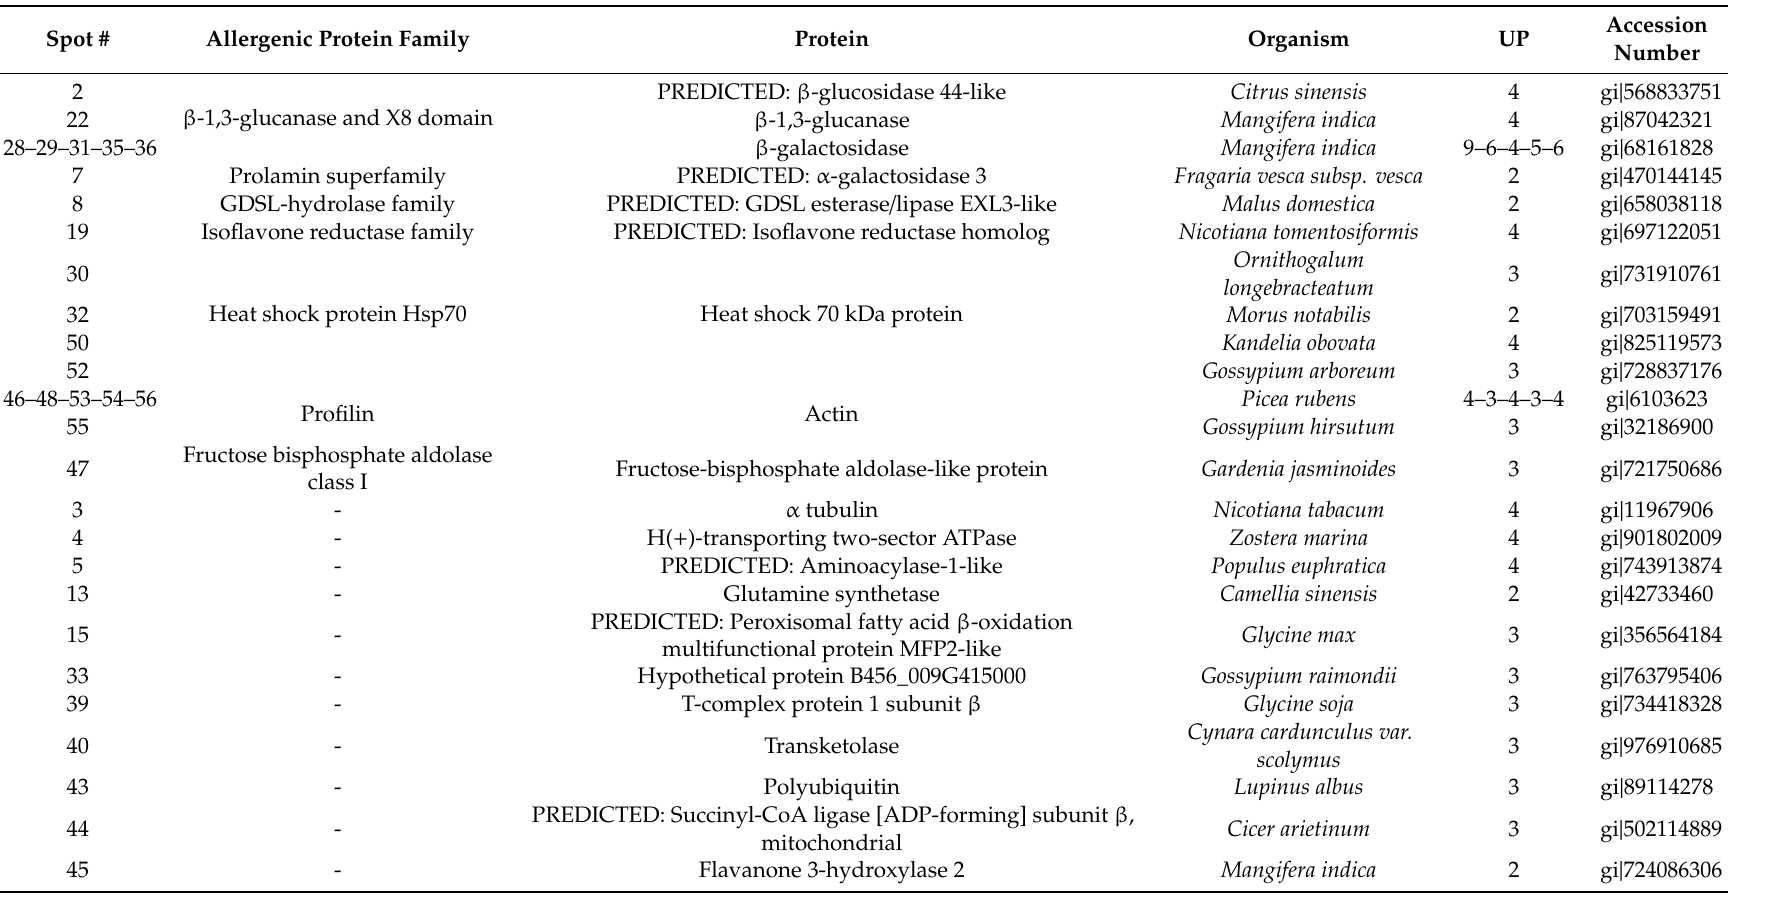
Table 3. Allergenic protein families and immunoglobulin E (IgE)-reactive proteins identified in cashew tree pollen by 2D-LC-MS /